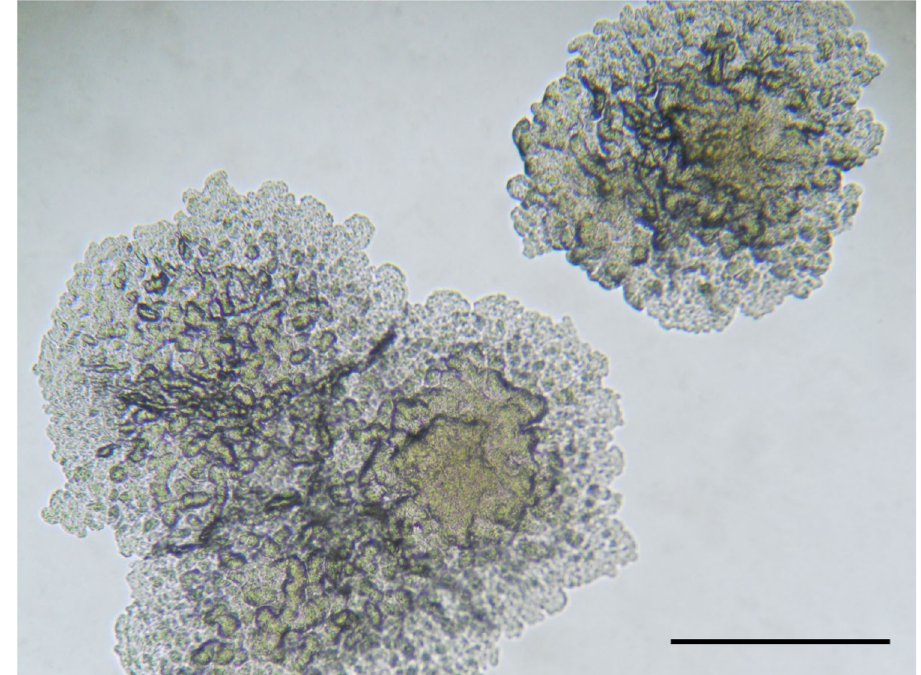
Fig. 1 Image of colonies from the Rwandan Lineage 8 strain. Isolate grown on solid medium, with the typical rough morphotype of Mycobacterium tuberculosis . Colonies grown on Dubos agar medium were visualized by microscopy. The scale bar represents ~2 mm.